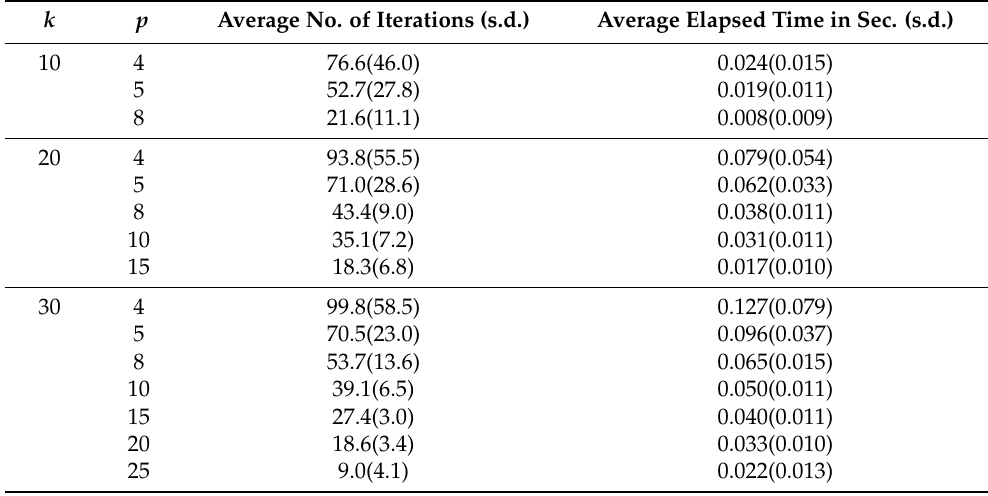
Table A5. The average number of iterations and average elapsed time of the ED -optimal